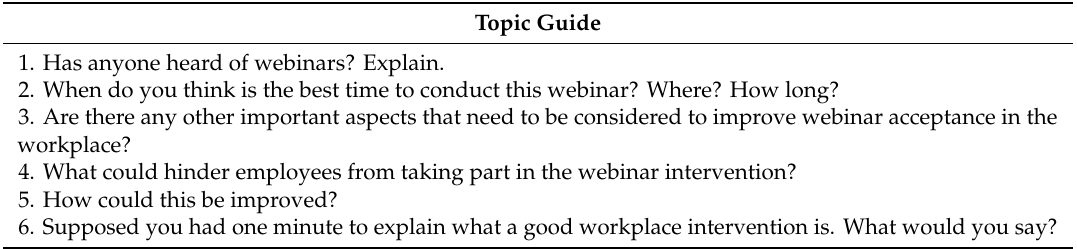
Table 1. Focus groups topic guide.